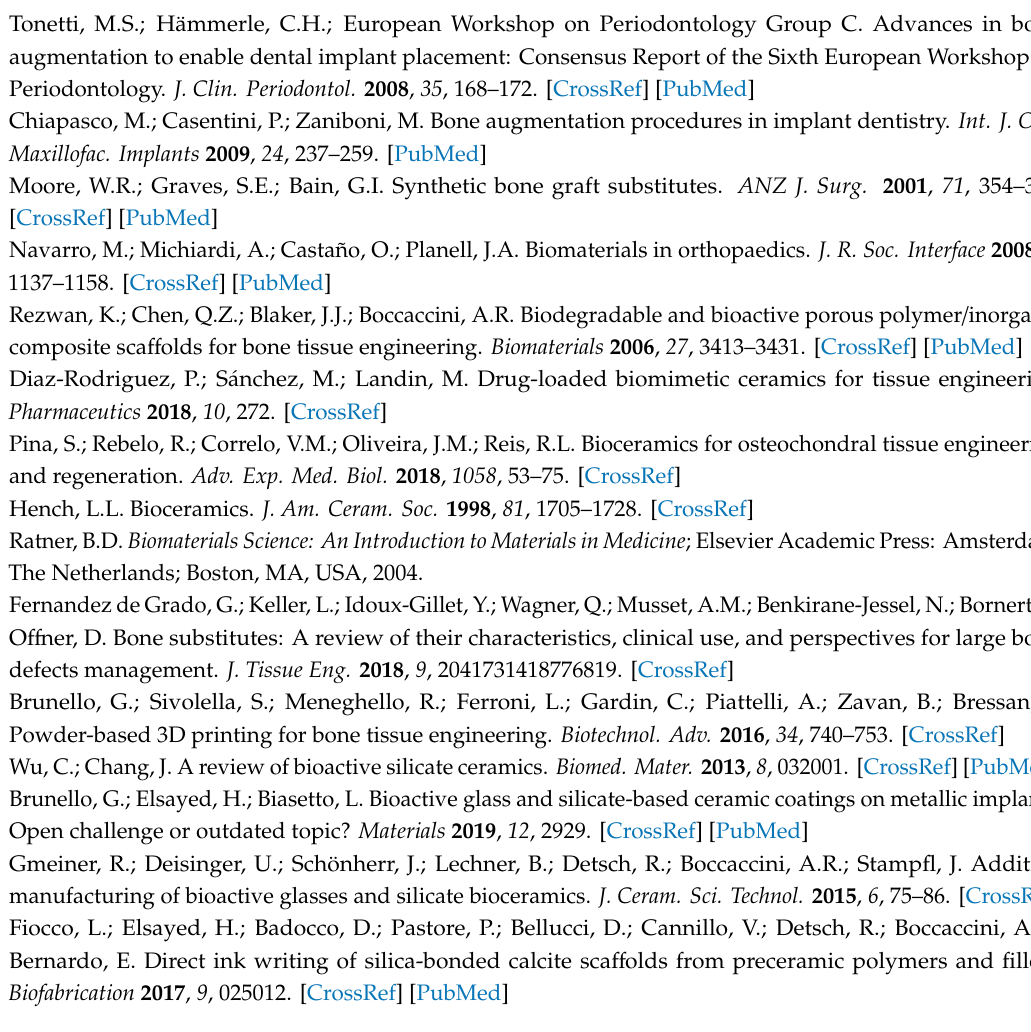
Table S1. Search strategies used for Web of Science (WoS) and Medline (PubMed) and related results; Table S2. Categories to assess the quality of the included